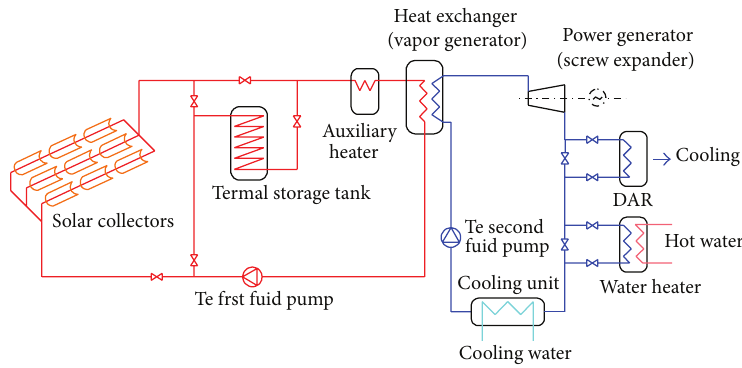
Figure 1: Conceptual flow chart of the modular solar thermal CCHP